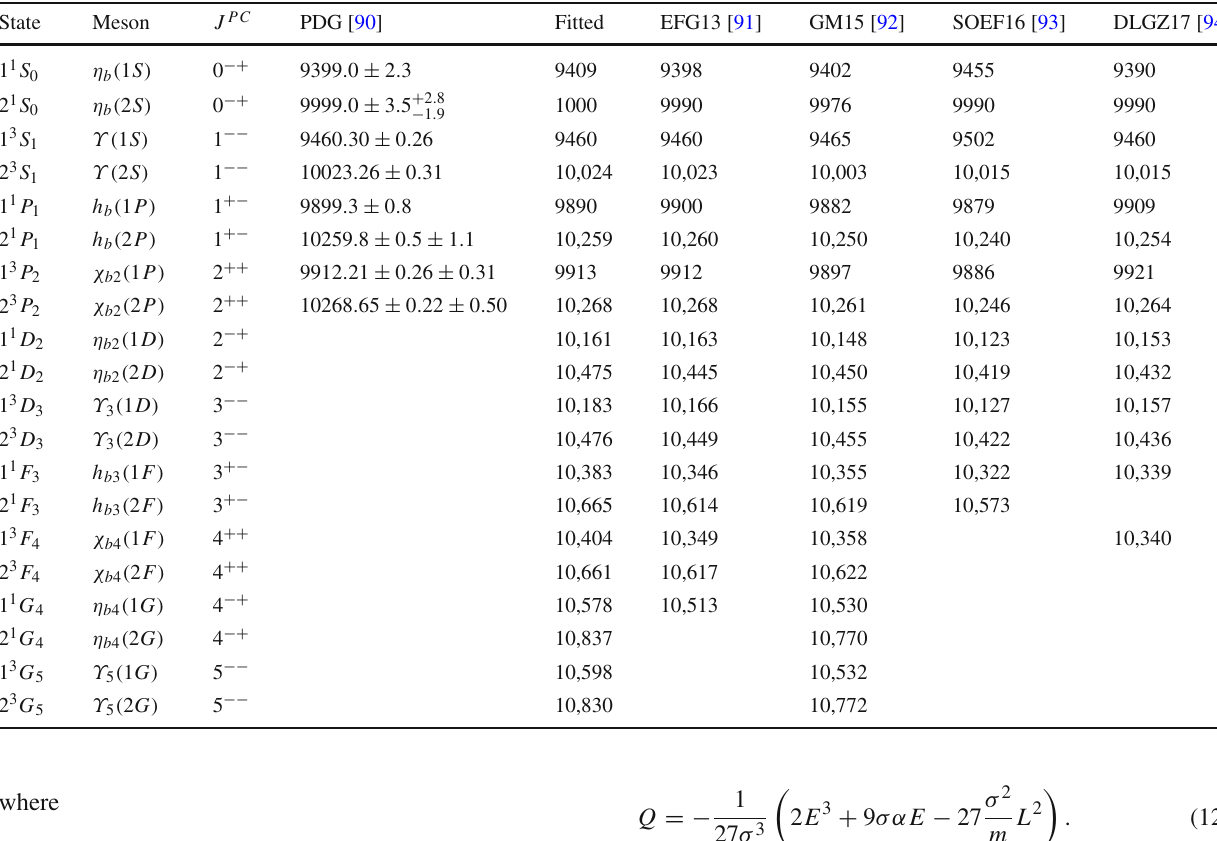
Table 2 Bottomonium masses (in units of MeV) fitted by the orbital Regge trajectories [Eq. (26)]. The experimental masses are from PDF [90]. The fitted results by using the Regge trajectories [Eq. (26)] are